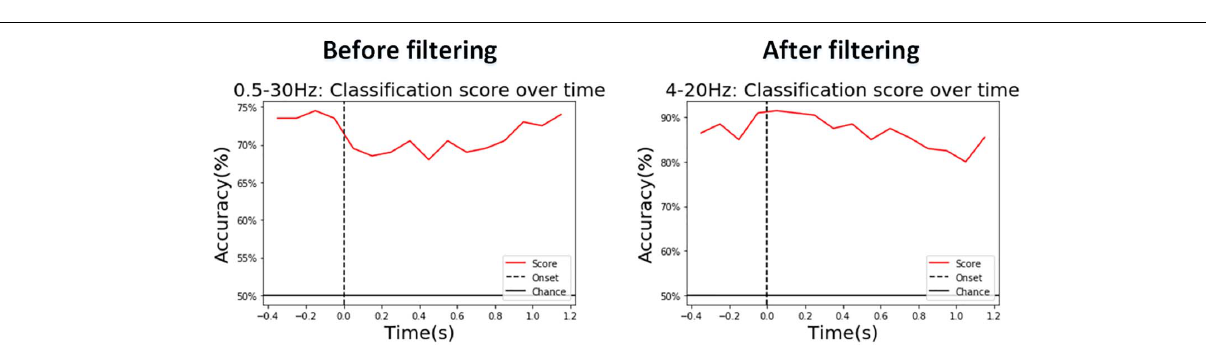
FIGURE 13 | A representative in the vibration task: A sliding-time window with a length of 500 ms and a step length of 100 ms used for real-time performance evaluation before and after the frequency band we